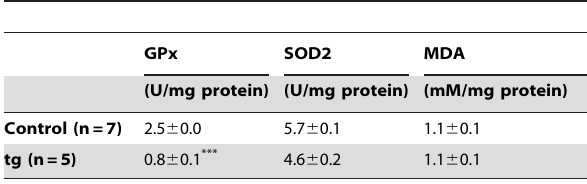
Table 1. Enzyme activities of GPx, SOD2 and MDA in the liver of control and HBV transgenic mice.